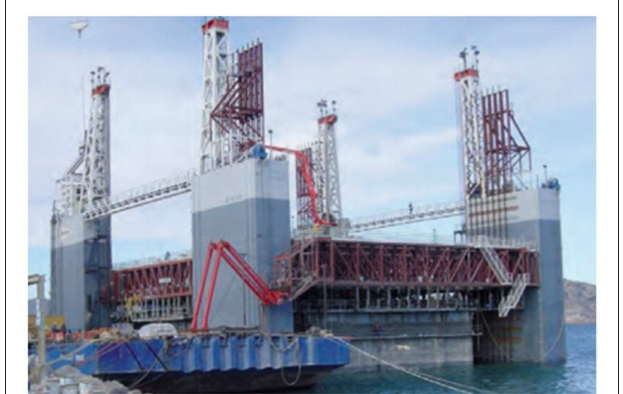
FIGURE 5 | Floating